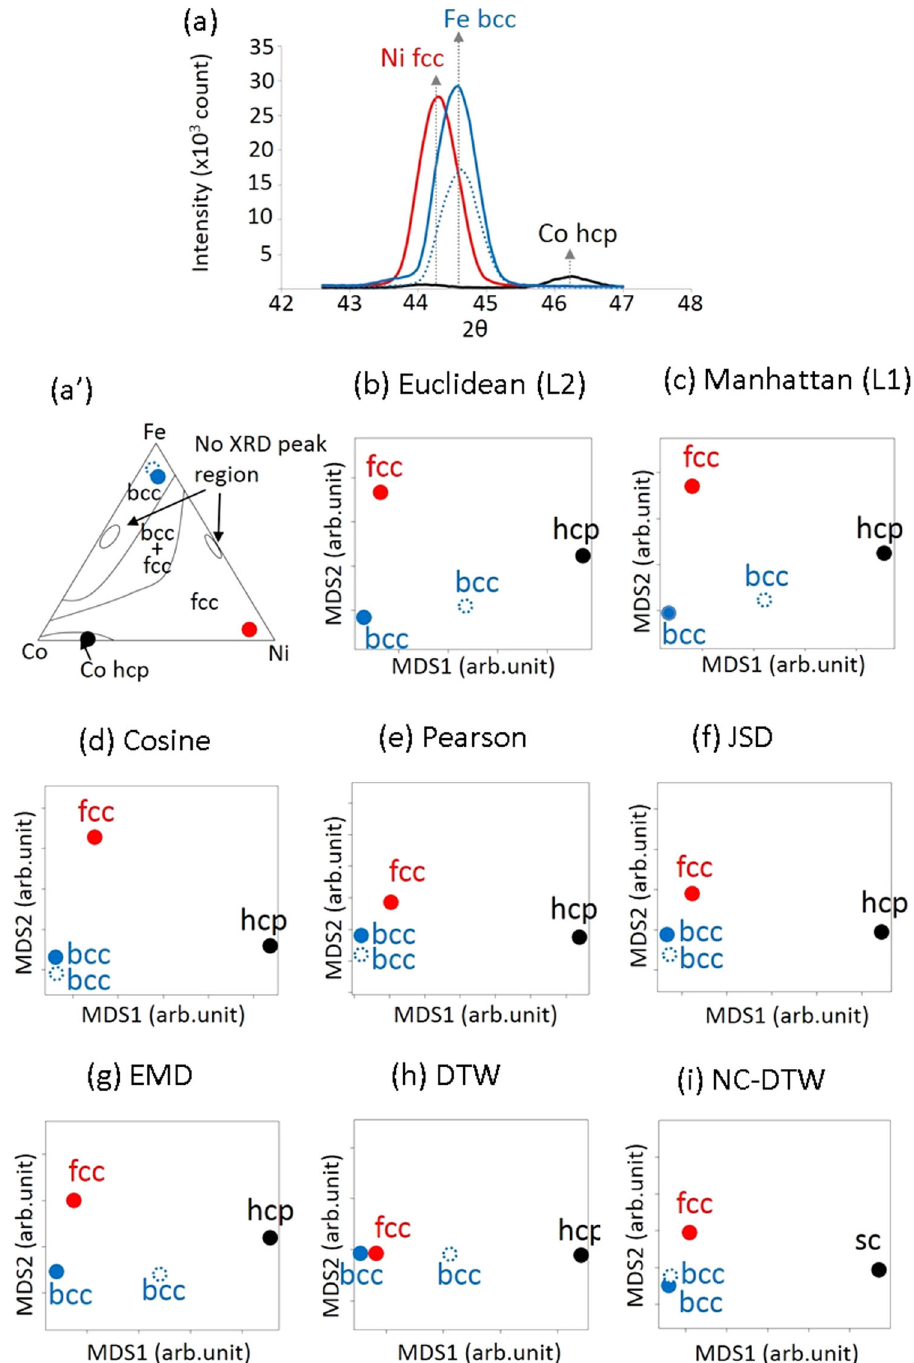
Fig. 5 Result of the MMDS analysis. a Four selected XRD patterns. The solid-blue and dotted-blue are form the bcc phase. The solid-red and solid- black are fcc and hcp structural phase, respectively. a ′ Composition mapping for four selected XRD patterns. b – i Result of the 2D MMDS analysis with different metric. b Euclidean metric. c Manhattan metric. d Cosine metric. e Pearson metric. f Jensen – Shannon Divergence. g EMD. h DTW i intensity differences. The cosine, Pearson and JSD metrics permit us to separate the different structural phases and cluster the same structural phases in the de fi ned space. identi fi ed as arising from the same/equivalent re fl ections. The EMD and DTW were expected to take care of the peak shift issue